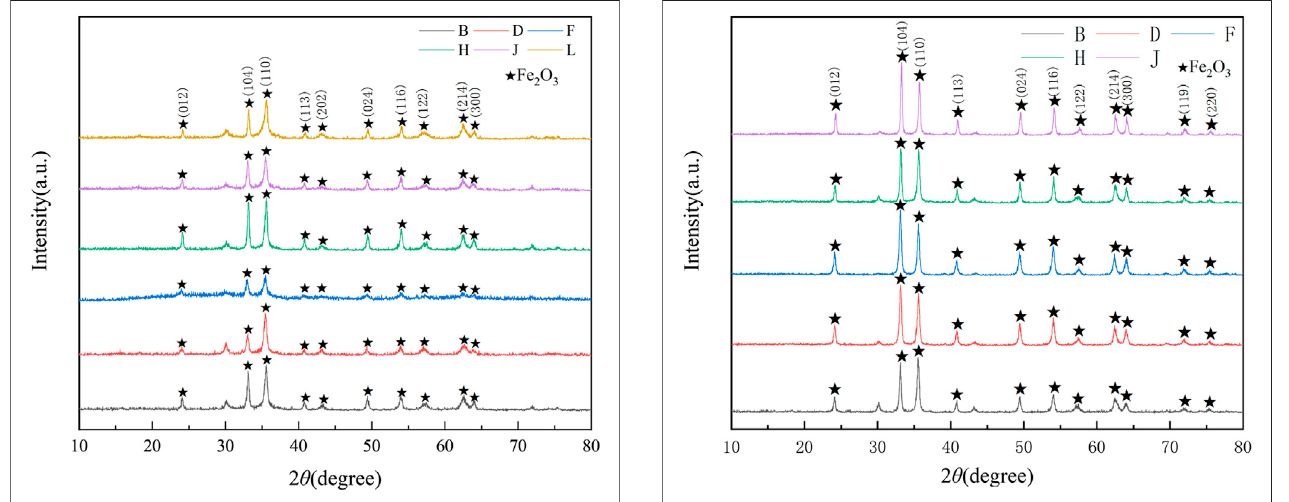
FIGURE 6 | XRD patterns of the pyrolysis products obtained at different FeCl